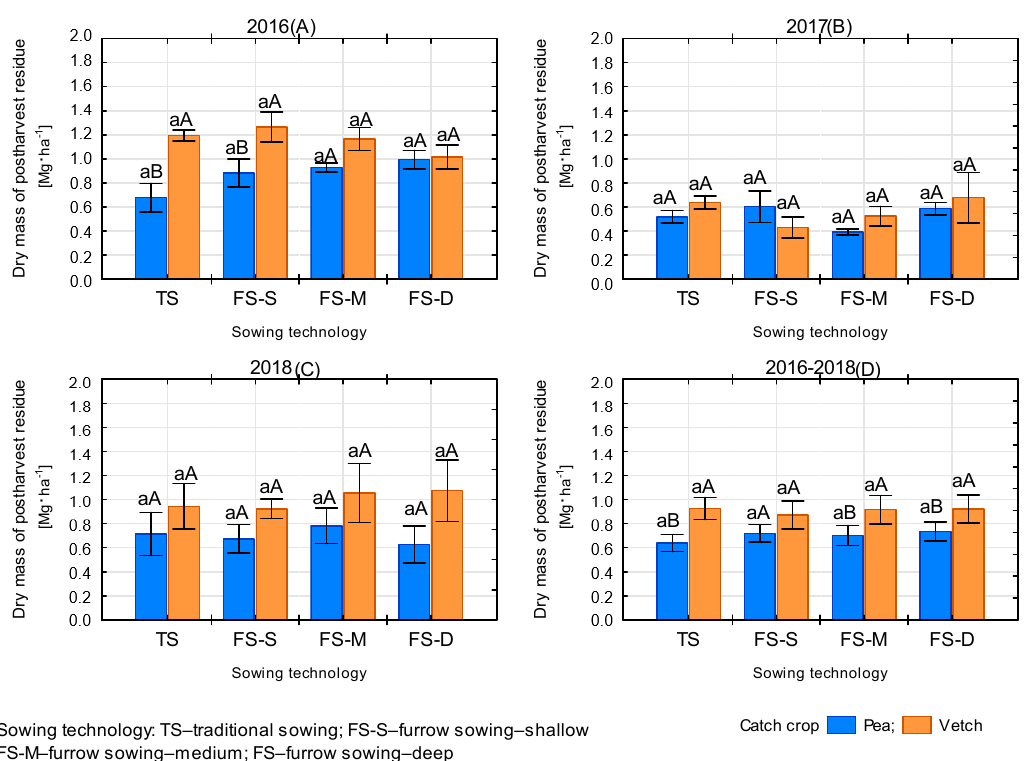
Figure 12. Interaction between factors in shaping the post-harvest residue dry mass yield of catch crops [Mg ha − 1 ]. a,b—homogenic groups HSD ( p = 0.05) interaction for sowing method/species (the differences between the four methods of sowing separately for peas and separately for vetch). A,B—homogenic groups HSD ( p = 0.05) interaction for species/sowing method (differences between peas and vetch for each sowing method).